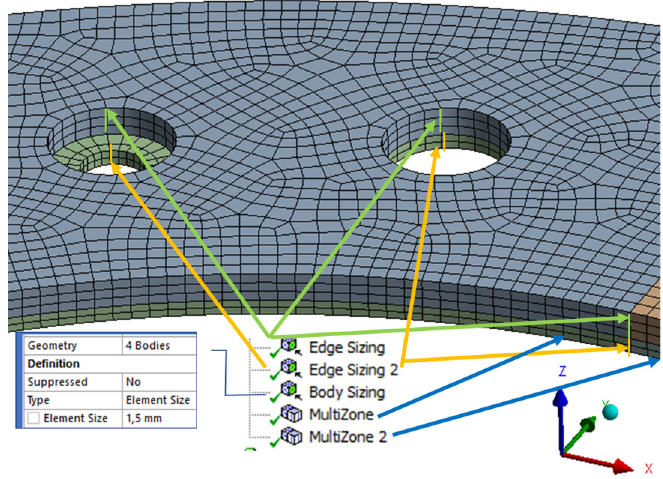
Figure A2. Applied mesh with hexagonal elements.